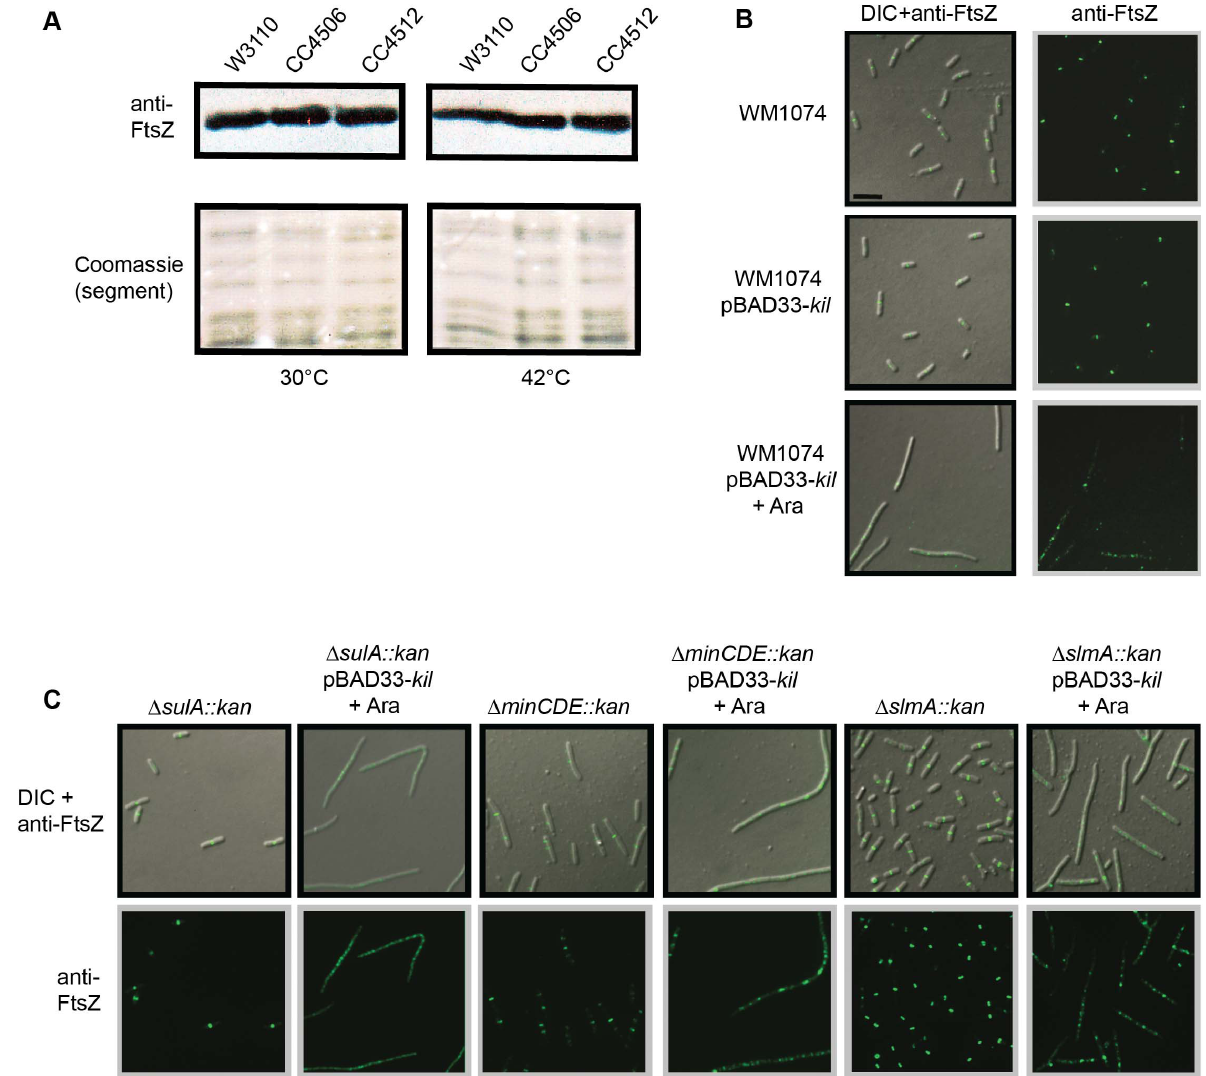
Figure 3. Kil does not alter FtsZ levels or act through SulA, the Min system, or SlmA. (A) FtsZ levels are unchanged by kil expression. Shown is an immunoblot against FtsZ (upper panels) from whole cell extracts of indicated strains harvested after 40 minutes of growth at 30 u C (left panels) or 42 u C (right panels). Relative levels of total protein are shown as a segment of Coomassie stained lanes (bottom panels). (B) Expression of kil in an MG1655-derived WM1074 background also blocks FtsZ ring formation and causes cell filamentation. DIC (left panels) and a -FtsZ IFM (left & right panels) micrographs are shown from mid-log cultures (40 minute induction) of indicated strains. (C) Kil-dependent filamentation remains in cells lacking SulA, the Min system, or SlmA (WM1074 background). DIC (top panels) and a -FtsZ IFM (top & bottom panels) micrographs from fixed mid-log cultures (40 min induction) of indicated strains are shown. Scale for micrographs in (B)–(C) is indicated by 5 m m scale bar in (B).